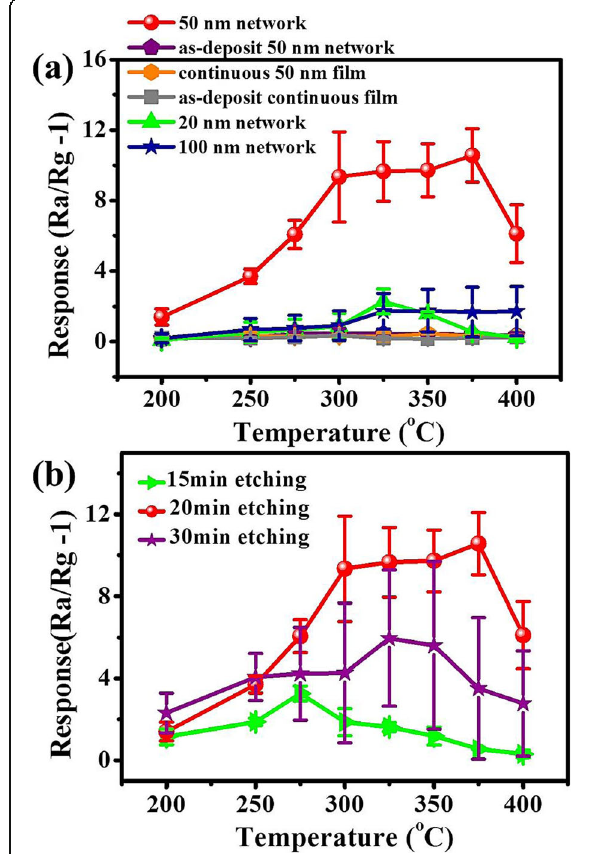
Fig. 6 Sensor responses of various samples towards 50 ppm ethanol vapor. a Gas responses of the six types of sensors, based on annealed 50-nm-thick SnO 2 :NiO network as-deposit 50-nm-thick SnO 2 :NiO network, annealed continuous 50-nm-thick SnO 2 :NiO film, as-deposit continuous 50-nm-thick SnO 2 :NiO film, annealed 20-nm- thick SnO 2 :NiO network, and annealed 100-nm-thick SnO 2 :NiO network, respectively. b Gas responses of the sensors fabricated